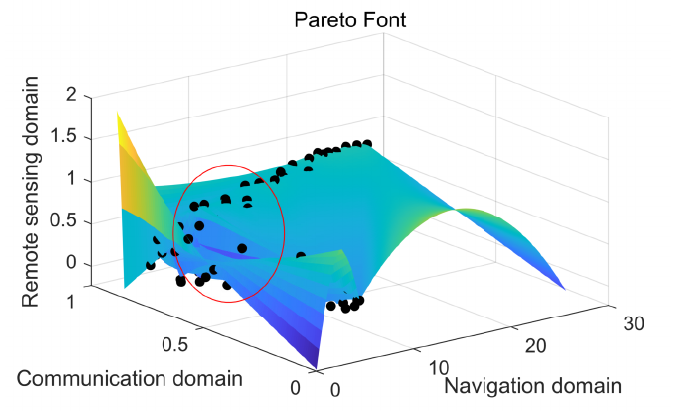
Figure 4. Pareto front end diagram of three functional